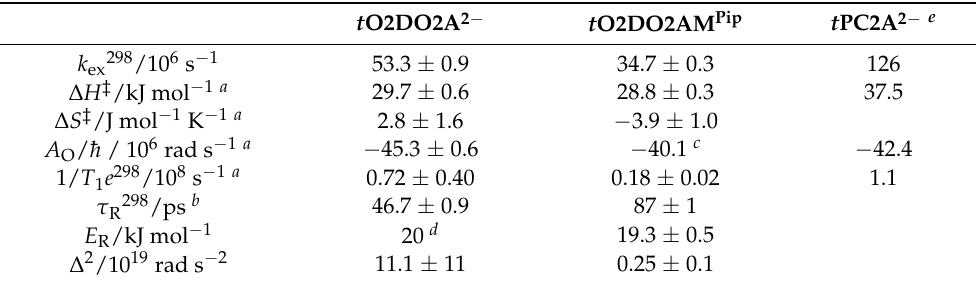
Table 5. Best-fit parameters obtained from the analysis of reduced relaxation 17 O NMR rates and NMRD profiles of [Mn( t O2DO2A )(H 2 O)] and [Mn( t O2DO2AM Pip )(H 2 O)] 2+ recorded at 9.4 T and related ligands. t O2DO2A 2 − t O2DO2AM Pip t PC2A 2 −